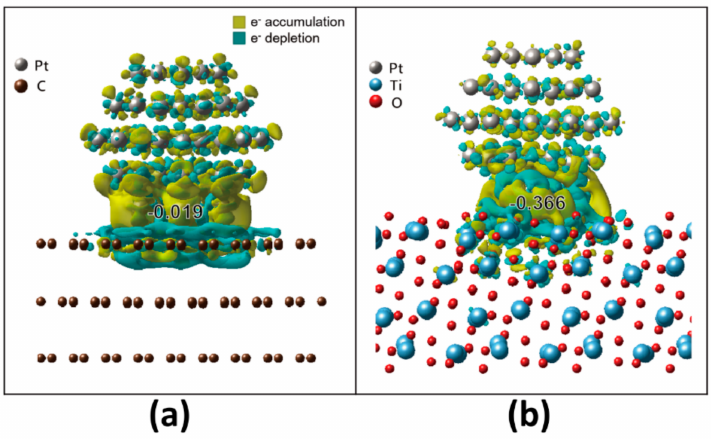
Figure 2. Simulated charge distribution of ( a ) Pt/C and ( b )